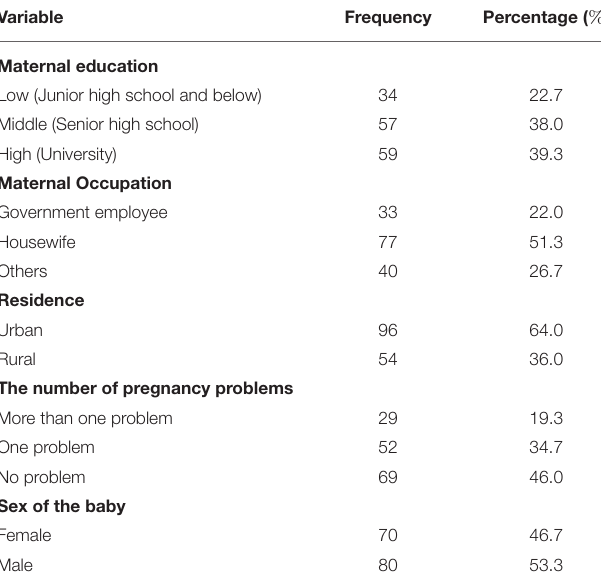
TABLE 5 | Summary statistics of category independent variables.